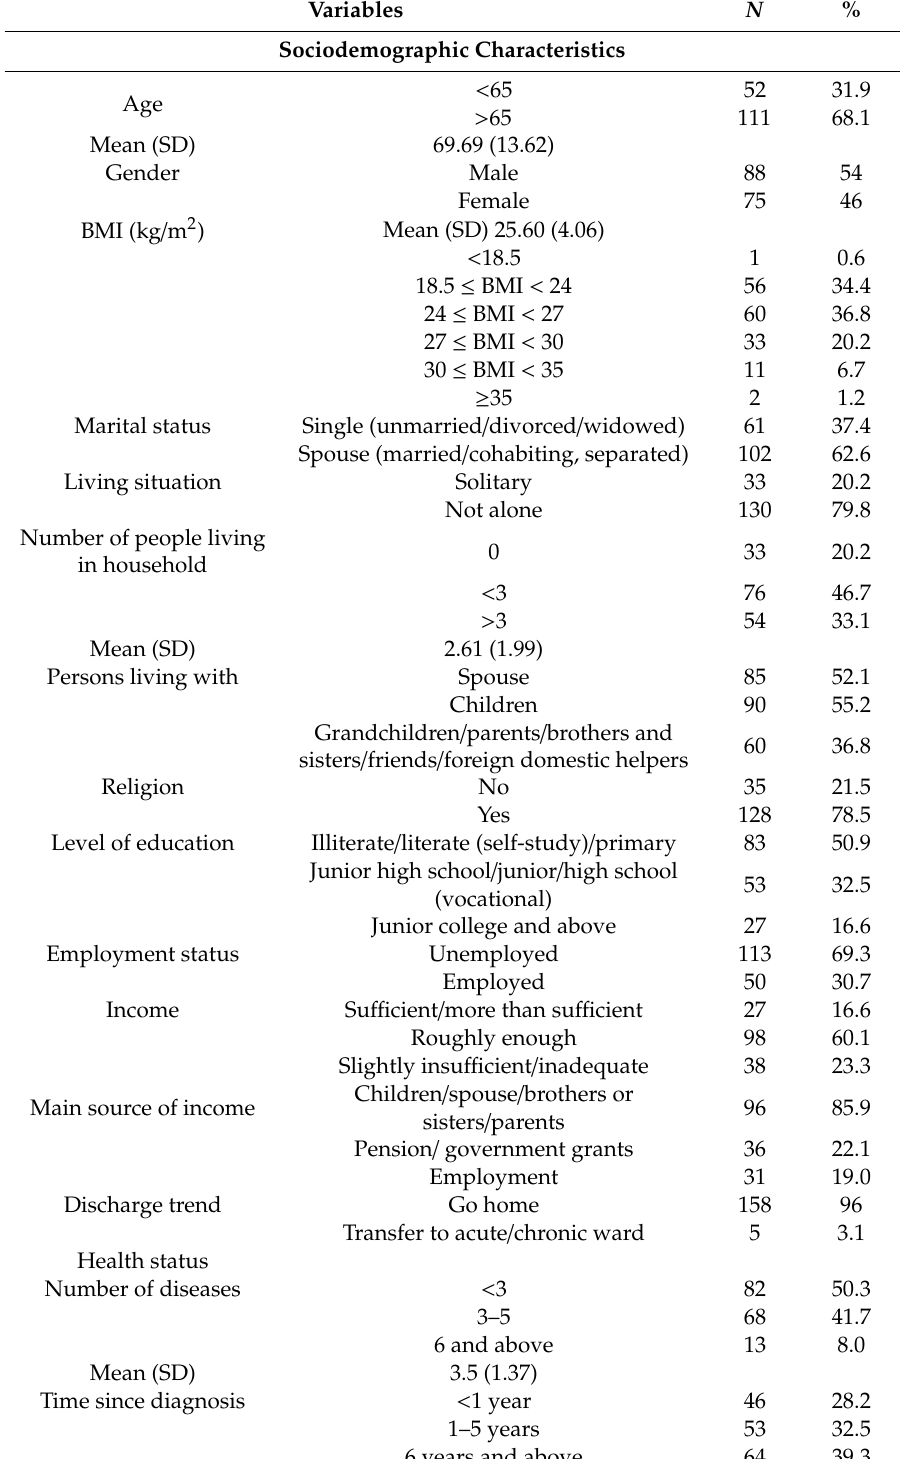
Table 1. Social characteristics and health status of subjects ( N =